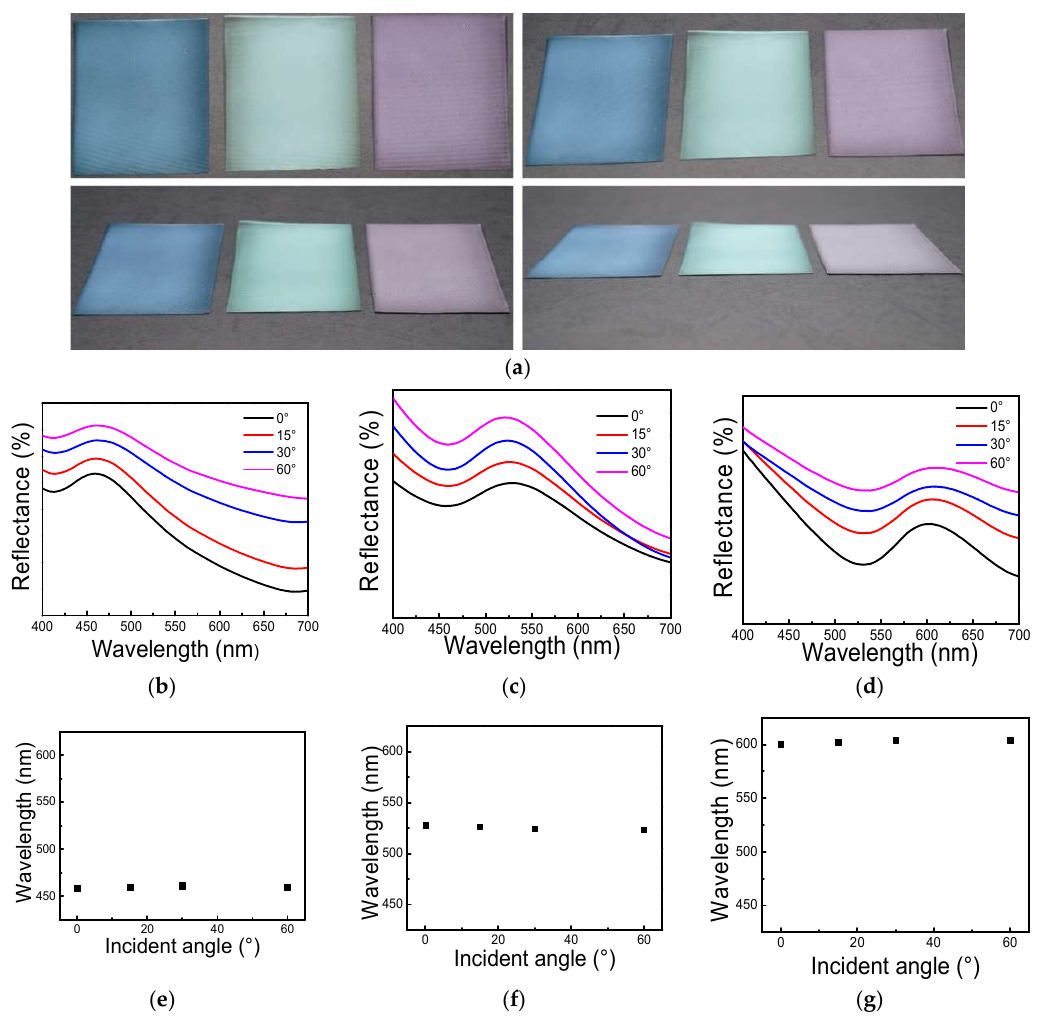
Figure 3. Optical properties of the non-iridescent structurally colored fabrics. ( a ) Photographs of the blue, green and red structurally colored fabrics under different viewing angles. ( b – d ) Reflectance spectra of the blue, green and red structurally colored fabrics with different viewing angles. ( e – g ) Plots of the positions of the reflection peaks of the three kinds of structurally colored fabrics versus the light incident angle.